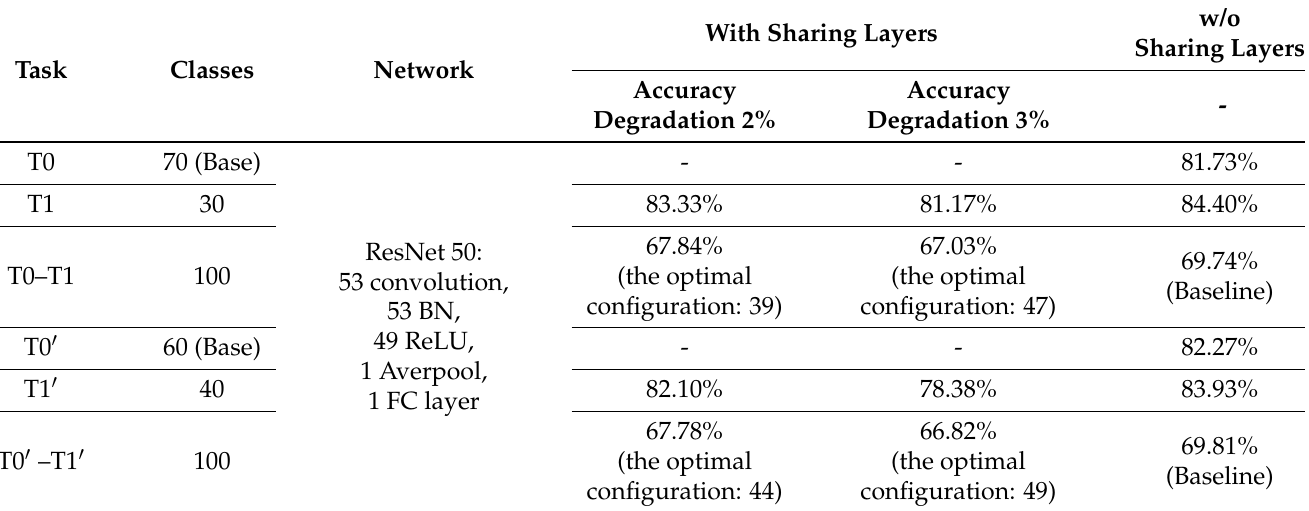
Figure 6. Visualization results of the optimal sharing layer configuration through BayesOpt as threshold accuracy degradation is 3% less than the baseline accuracy. (70 classes/30 classes) ( a ) The result of the selected optimal number of sharing layers. ( b ) The L2 distance of the consecutive observed points. ( c ) The value of the calculated best-selected sample for every iteration. Table 1. Experimental results on the proposed algorithm in CIFAR-100 (Case